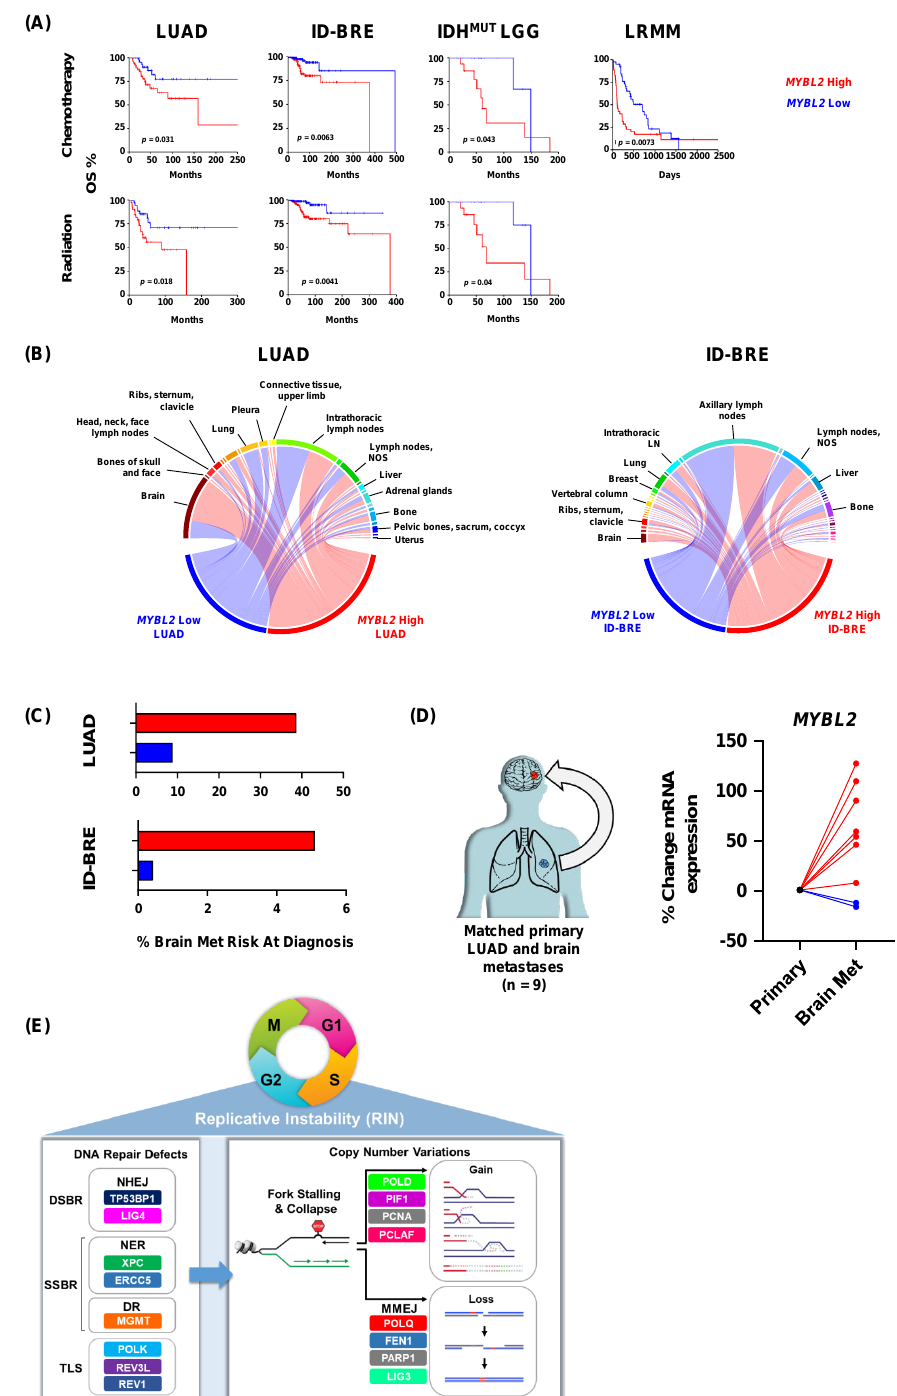
Figure 6. Elevated MYBL2 expression identifies patients at risk for poor responses to therapy and distant metastases across tumor types. ( A ) MYBL2 High patients have significantly poorer outcomes when treated with chemotherapy and irradiation regimens. Log-rank test p -values are displayed. ( B ) MYBL2 High tumors metastasize to distant sites at a higher frequency, including to the brain. ( C ) MYBL2 expression stratifies patient risk at diagnosis for brain metastasis development. LUAD: lung adenocarcinoma. ID-BRE: Invasive ductal breast cancer. IDH MUT LGG: IDH-mutant lower grade glioma. LRMM: Late relapse multiple myeloma. ( D ) MYBL2 expression is increased in brain metastases compared to patient matched primary lung adenocarcinoma tumors. ( E ) Replicative instability (RIN) accelerates genome evolution, driving cancer